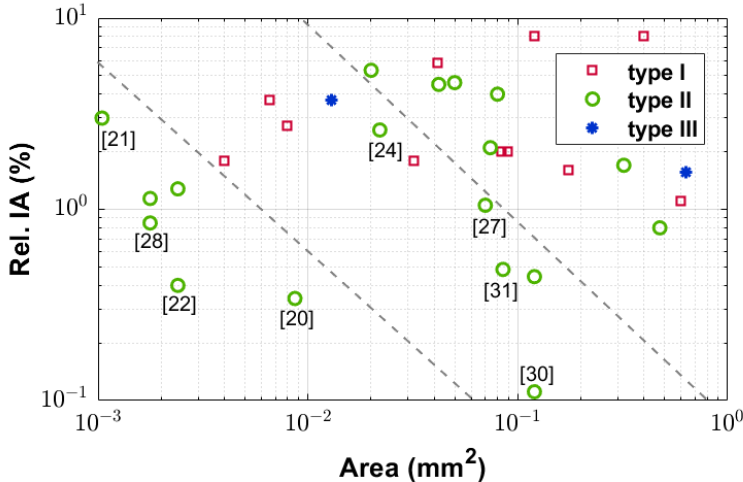
Figure 15. The relative inaccuracy (Rel. IA) versus area, for all three types of MOS-based temperature sensors. The figure also shows the constant Rel. IA and area product lines (gray dashed lines). The reference numbers are labelled next to the markers for type II sensors.